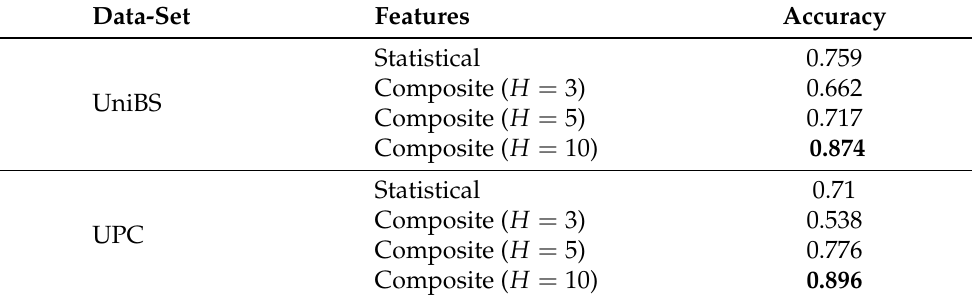
Table 4. Accuracy achieved by the support vector machine (SVM) classifier.